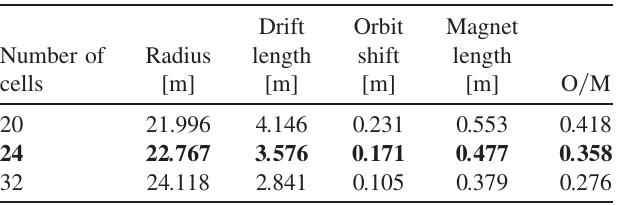
TABLE III. Geometrical lattice parameters as a function of number of cells for a 2 : 25 GeV =c machine, that is a kinetic energy of 1.5 GeV for a proton. Number of